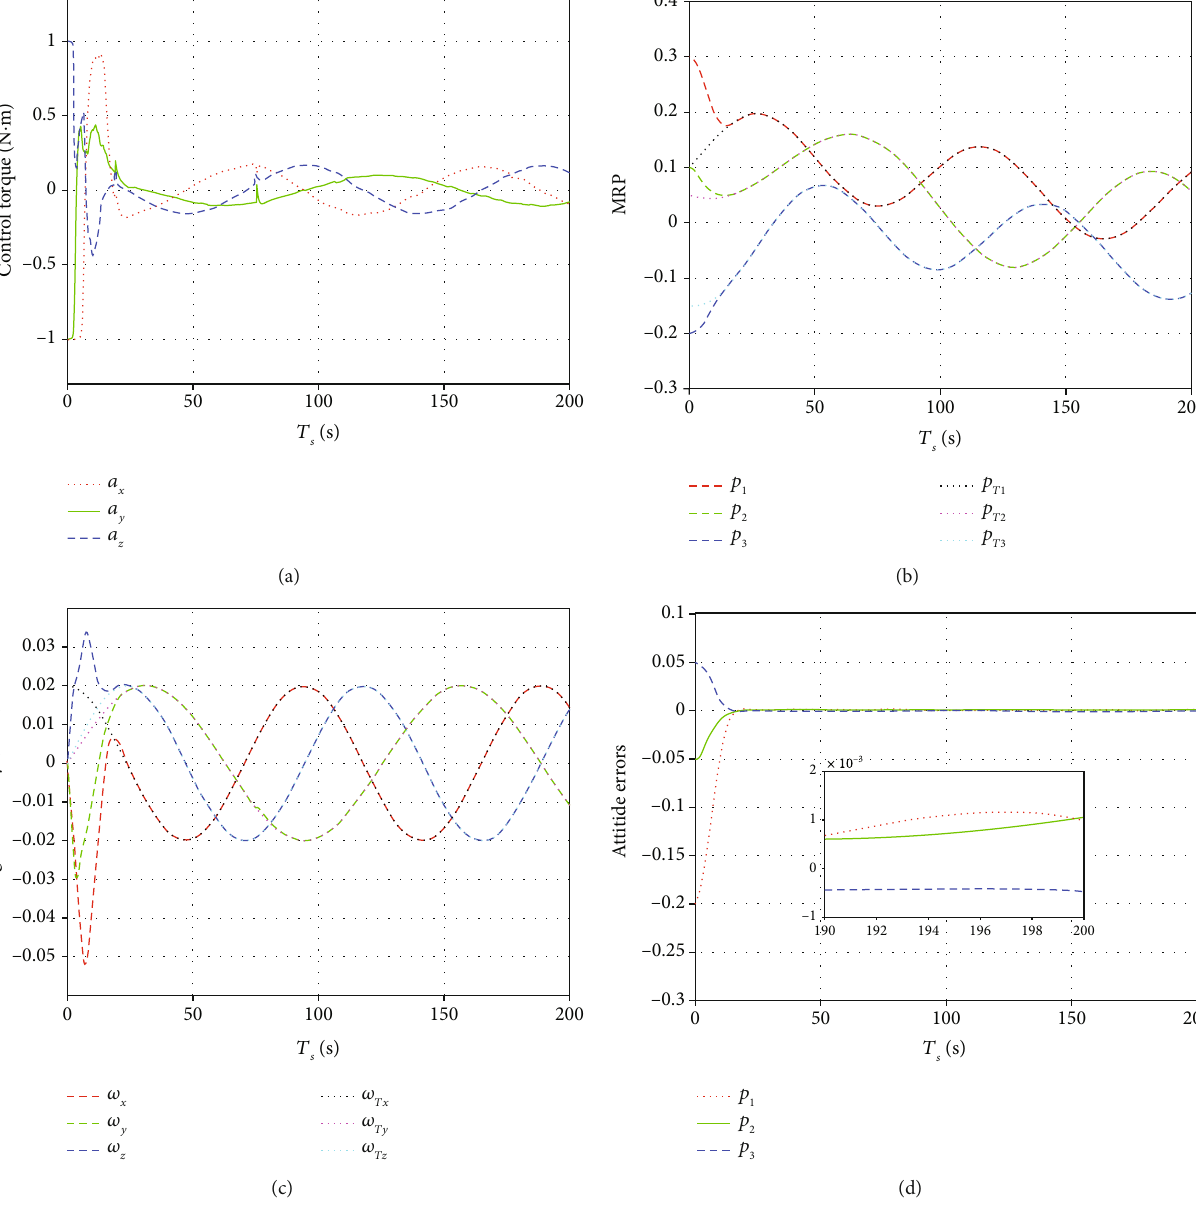
Figure 6: Attitude tracking using the DRL controller under ideal environment: (a) time response of control torque; (b) time response of MRP; (c) time response of angular velocity; (d) the attitude error